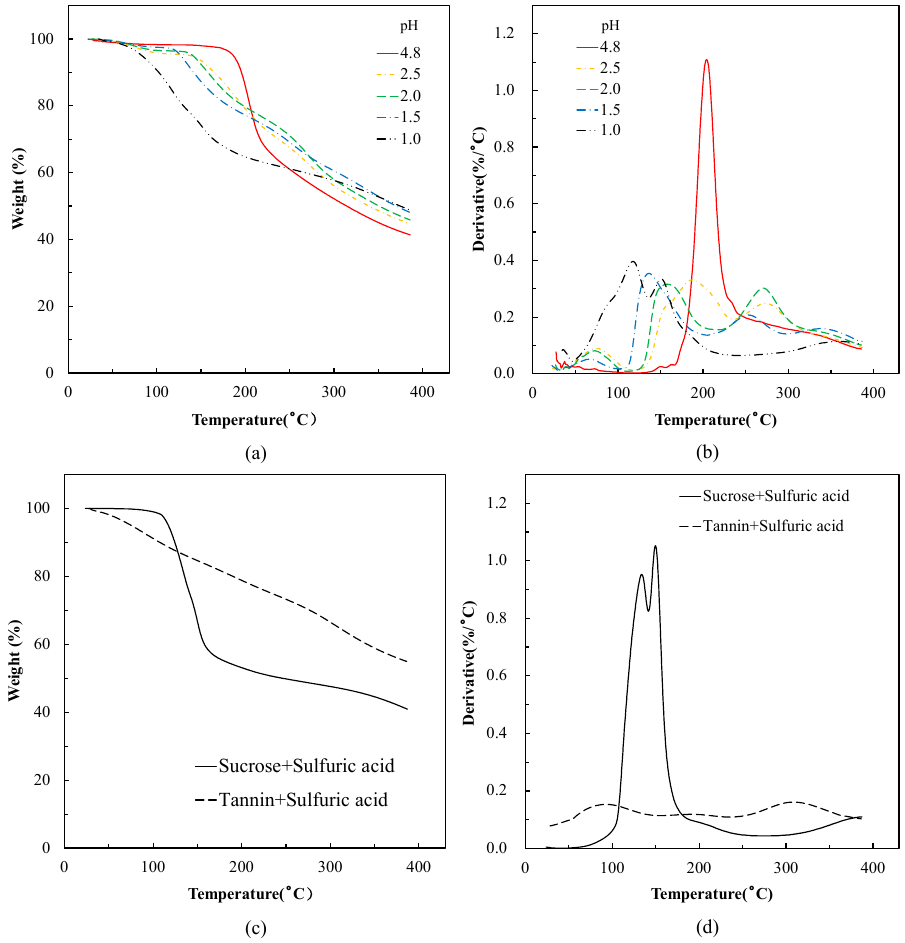
Figure 1. Thermogravimetric (TG) and derivative TG (DTG) curves of mixtures. ( a ) TG curves of tannin–sucrose–sulfuric acid mixture with different pH; ( b ) DTG curves of tannin–sucrose–sulfuric acid mixture with different pH; ( c ) TG curves of tannin–sulfuric acid and sucrose–sulfuric acid mixture at pH = 1.0; ( d ) DTG curves of tannin–sulfuric acid and sucrose–sulfuric acid mixture at pH = 1.0.